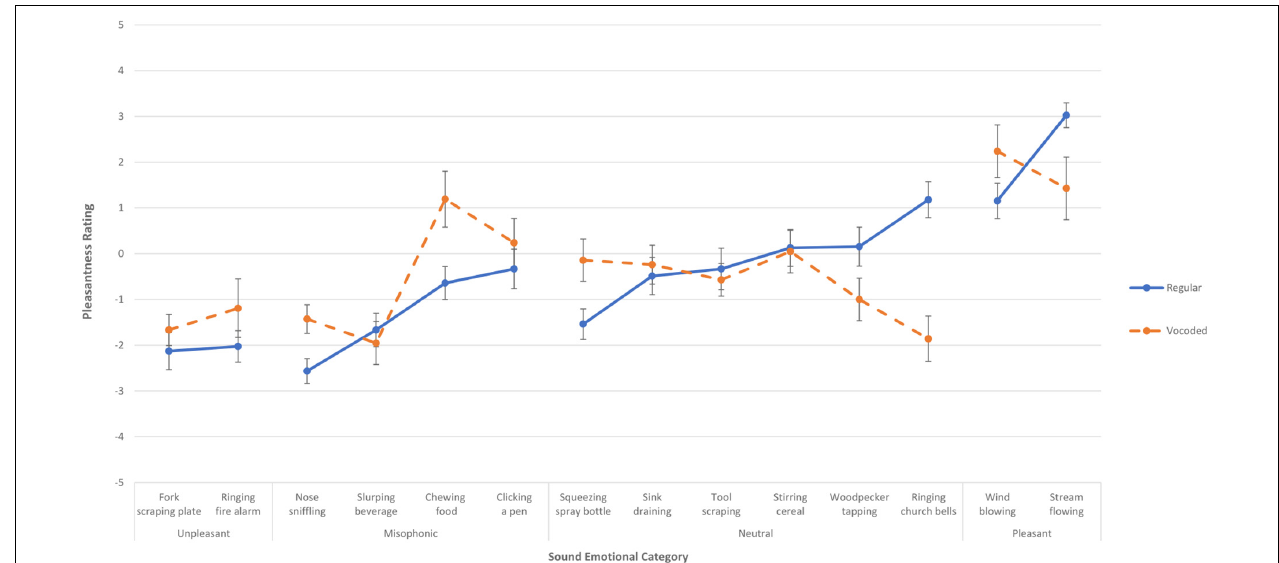
FIGURE 3 | Mean pleasantness rating for each of the fourteen sounds when presented in Experiment 1, with no vocoding (solid blue lines), and when presented in Experiment 2 as vocoded (dashed orange lines). The error bars indicate the standard error of the mean across the sounds. Each of the fourteen sounds is plotted in its a priori emotional category, with the far-left, left, right, and far-right denoting the categories of unpleasant, misophonic, neutral, and pleasant. The more pleasant a sound is rated, the higher on the y axis it is placed.